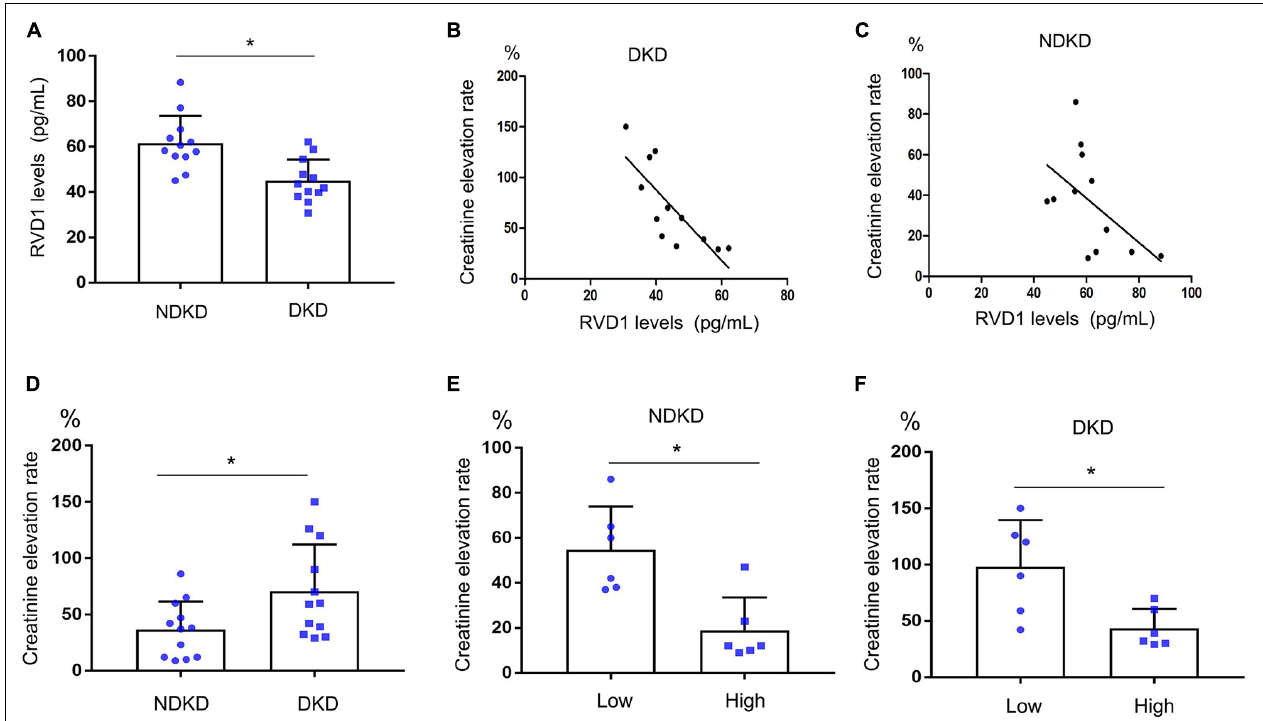
FIGURE 1 | Decreased serum resolvin D1 (RvD1) was responsible for the susceptibility to ischemic acute kidney injury (AKI) in diabetic kidney disease (DKD) patients. Creatinine elevation rate: [(post-surgery serum creatinine level - pre-surgery serum creatinine level)/pre-surgery serum creatinine level] * 100%. (A) Serum RvD1‘ B) Negative correlation between serum RvD1 with the creatinine elevation rate in the DKD group ( r = -0.7928, p = 0.0021, Spearman’s correlation test). (C) Negative correlation between serum RvD1 levels with the creatinine elevation rate in the non-diabetic kidney disease (NDKD) group ( r = -0.527, p = 0.078, Spearman’s correlation test). (D) Creatinine elevation rate in the DKD and NDKD groups. (E,F) Creatinine elevation rate in the NDKD and DKD subgroups. All the data are expressed as mean ± SD . * p < 0.05.